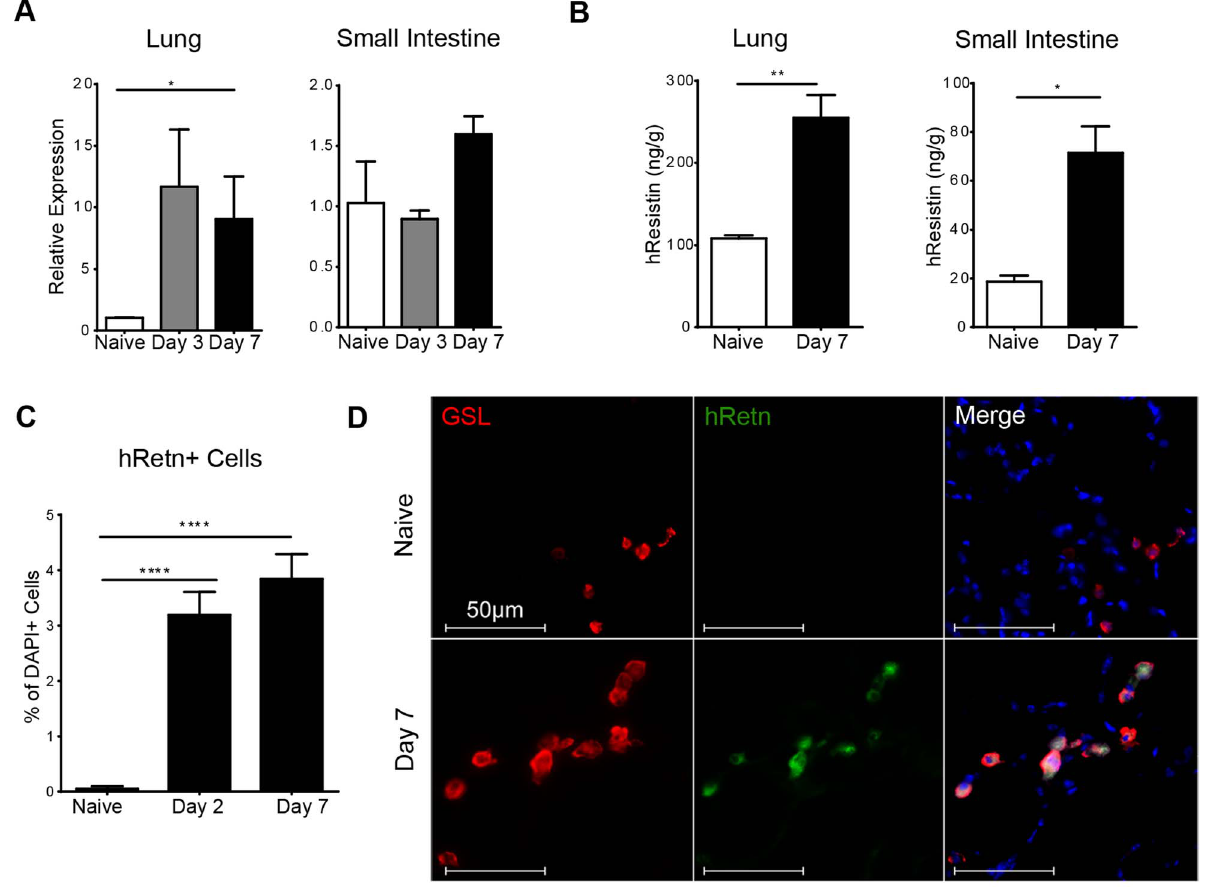
Fig. 1. Detection of hResistin expression in Nb -infected transgenic mice. (A-B) hResistin expression in the lung and small intestine of naı¨ve or Nb -infected mice was measured by real-time PCR analysis (A) or ELISA (B). (C) Quantification of hResistin expressing cells was performed on immunofluorescent stained lung sections. (D) IF staining for Griffonia simplicifolia lectin (red), hResistin (green), and DAPI (blue) was performed on lung tissue sections. Data (mean 6 SEM, n=4–6 per group) are representative of four separate experiments.